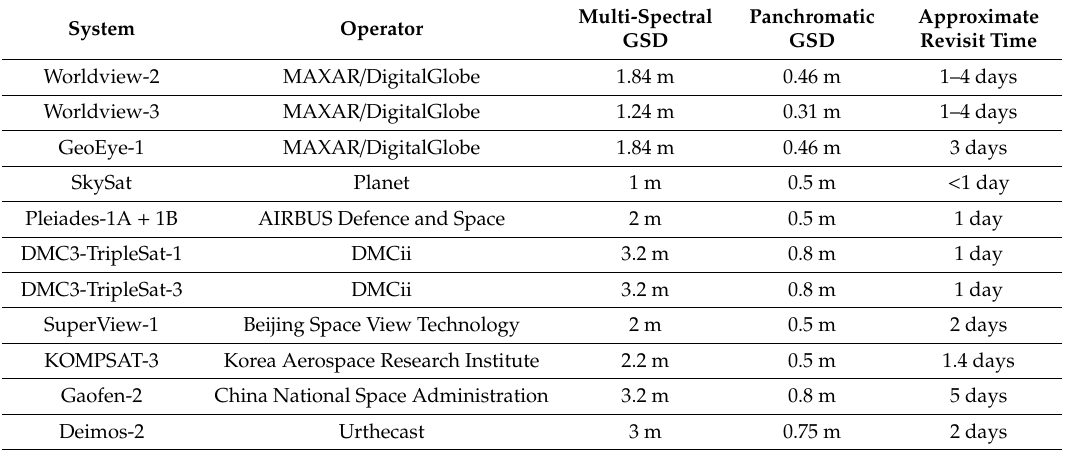
Table 1. Selection of existing very-high-resolution multi-spectral satellite imaging systems [21–24].